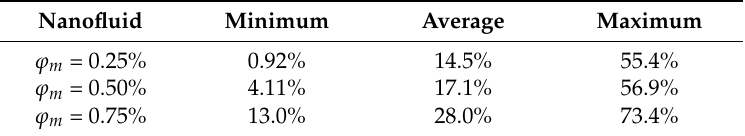
Table 2. Relative pressure drop in relation to pure water for graphene nanoplatelets water-based nanofluids.